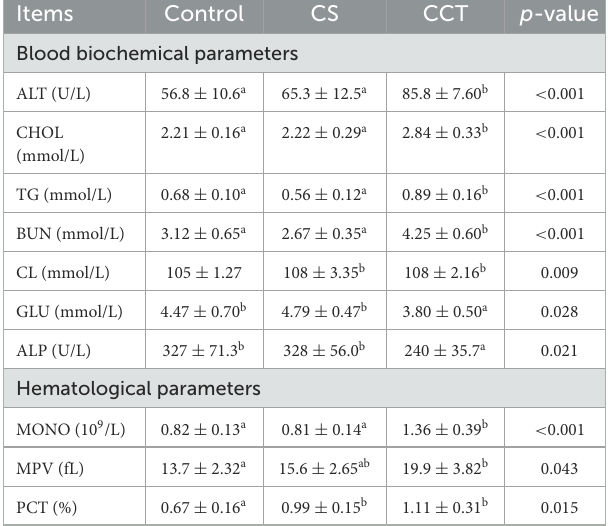
TABLE 3 Effects of CCT supplementation on blood biochemical parameters and hematological parameters in piglets before LPS